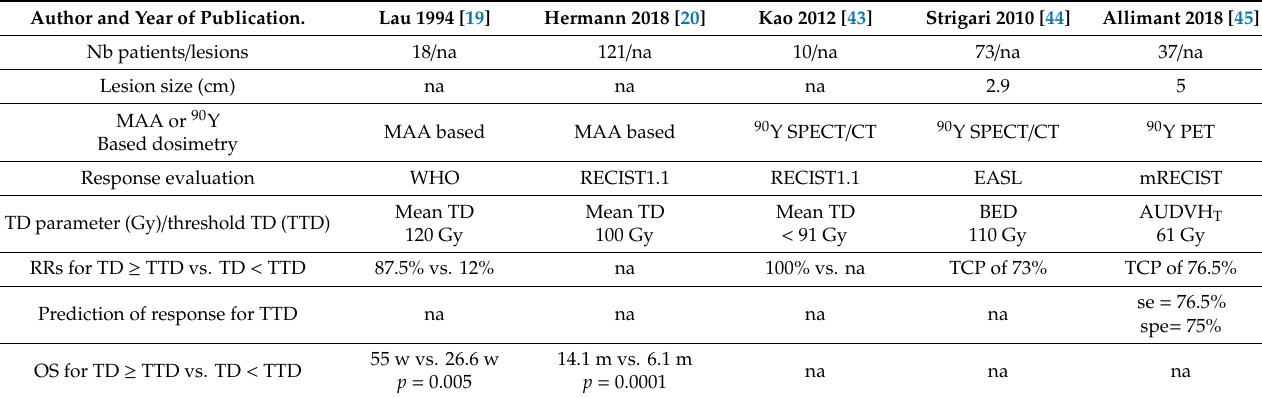
Table 2. Studies with tumor dose outcome correlation in HCC with resin